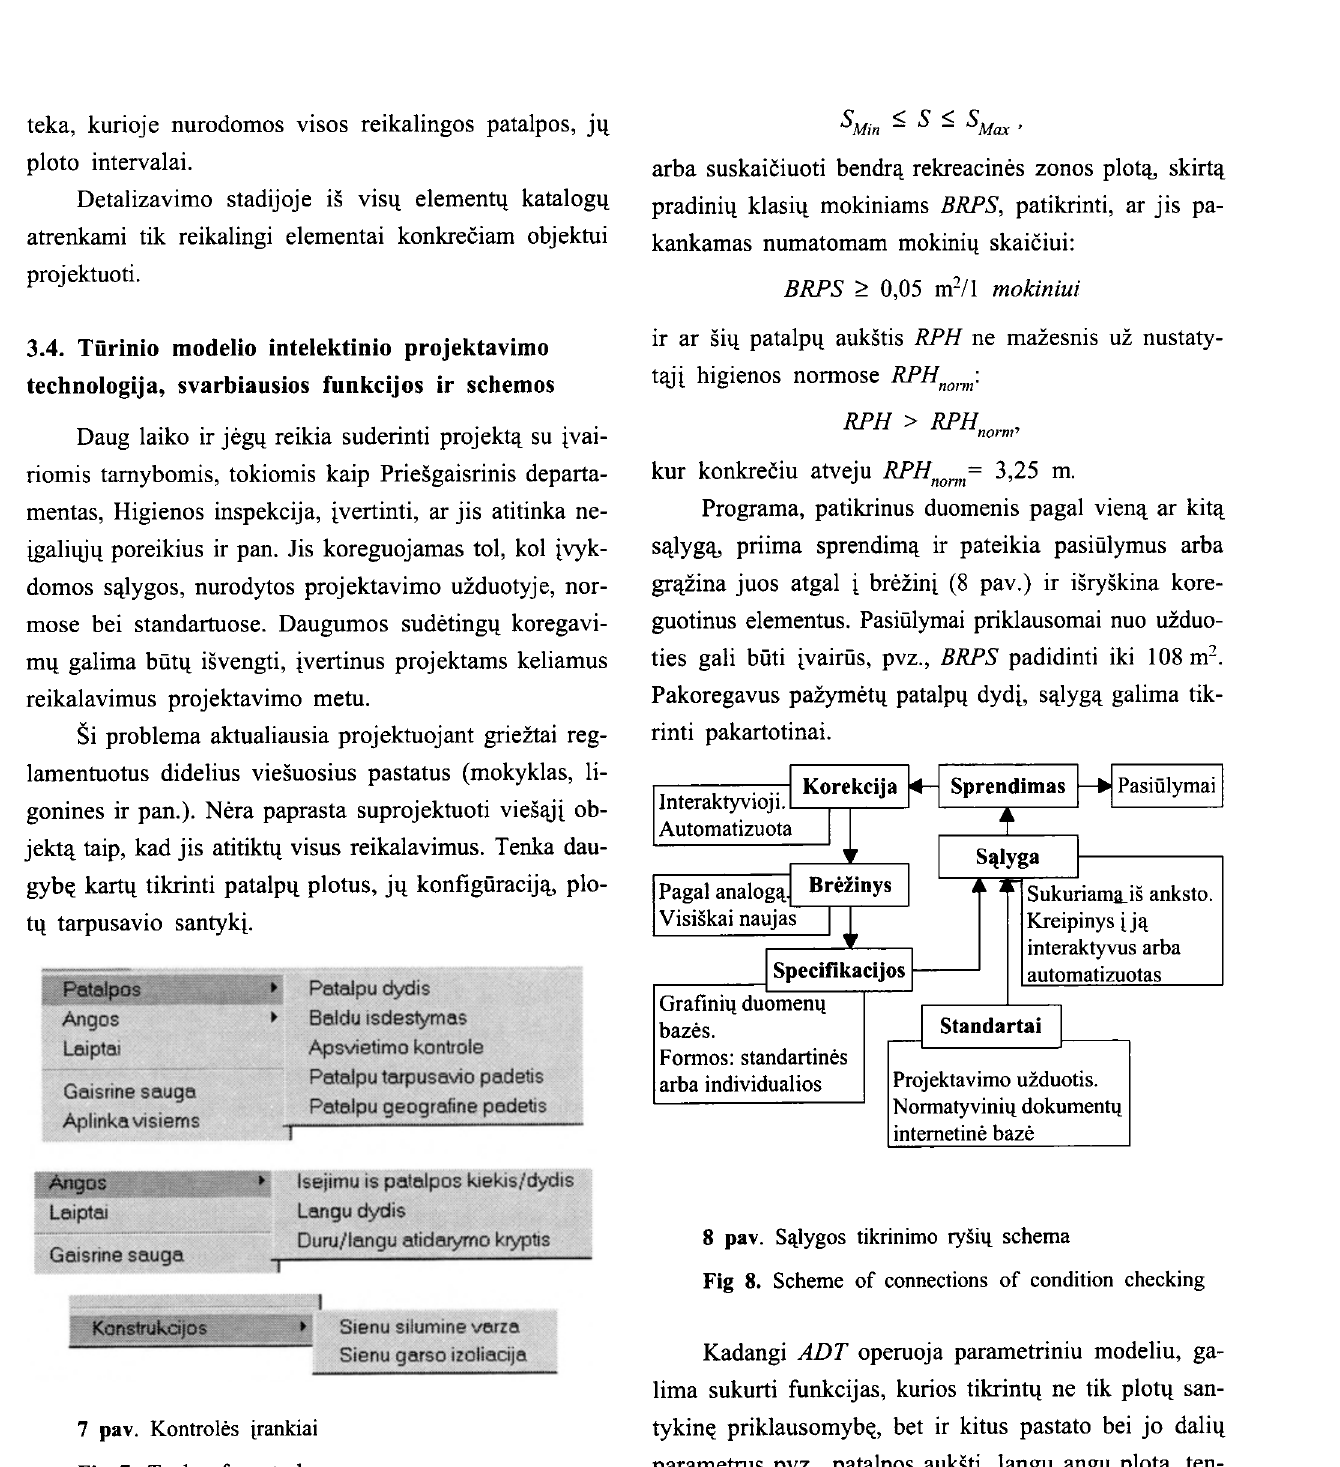
Fig 8. Scheme of connections of condition checking Kadangi ADT operuoja parametriniu modeliu, ga lima sukurti funkcijas, kurios tikrintq ne tik plotq san tykint( priklausomybt(, bet ir kitus pastato bei jo daliq parametrus pvz., patalpos auksti, langq angq plotq_, ten kanti patalpos grindq plotui, visus laiptq parametrus (pa kopos auksti ir ploti, marso ilgi, ploti), evakuaciniq is ejimq (koridoriq ir durq plotis) parametrus ir dar dau geli kitq. Zinant patalpq koordinates, galima patikrinti jq tarpusavio rysius ir pastato funkcint( struktiirq_. Pro grama, remdamasi ergonominiais reikalavimais, gali pa siiilyti optimalq baldq isdestymq_ patalpoje (mokykliniai suolai klasese) ir apskaiciuoti, kiek ir kokiq baldq rei kes visam